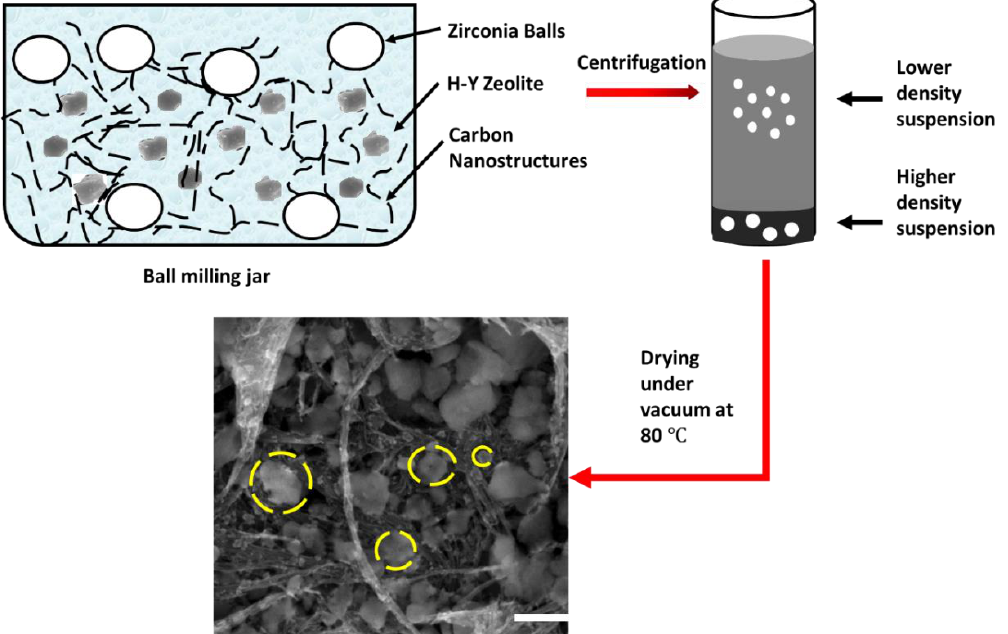
Figure 14. Composite catalyst fabrication procedure using ball milling. Ball-milled zeolite particles are indicated by yellow dashed circles, scale bar = 500 nm.